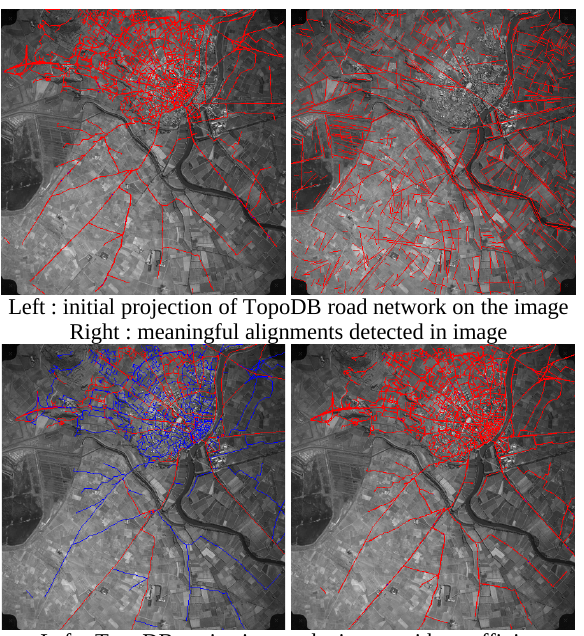
Left : TopoDB projection on the image with an affinity estimated by RANSAC algorithm (main roads are in red) Right : TopoDB projection with an homography estimated by line-based SoftPOSIT algorithm Figure 5. Registration of subsampled image from Agde